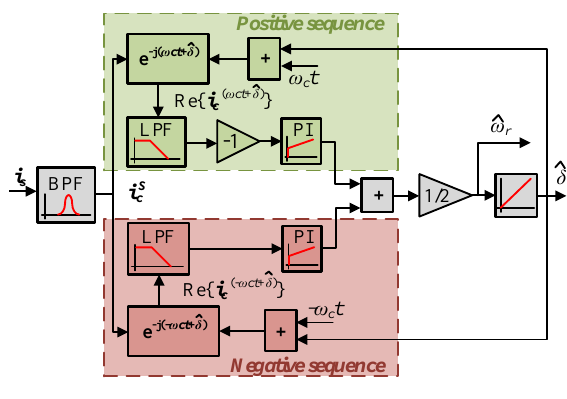
Figure 3. Proposed demodulation scheme using also the negative sequence